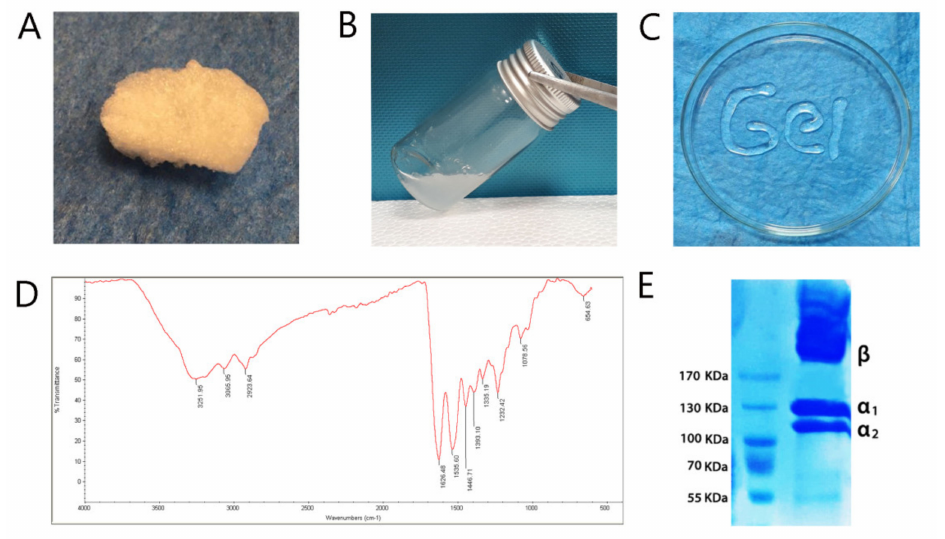
Figure 1. Characterization of collagen type I, which is extracted from rat tail. ( A ) The freeze-dried collagen; ( B ) the collagen solution at 7 mg/mL concentration; ( C ) self-assembled collagen, in pH 7.4 and 37 ◦ C was injected via a 0.7 mm diameter syringe; ( D ) The FTIR spectrum shows the presence of specific molecular vibrations such as amide A, amide B, amide I, amide II, and amide III, which certified the attendance of type 1 collagen structure; ( E ) The inclusion of monomer α 1 , α 2 , and β dimers and dimers in sodium dodecyl sulfate-polyacrylamide electrophoresis data revealed collagen type I structure. In addition, the same molecular weight (MW) was found between the